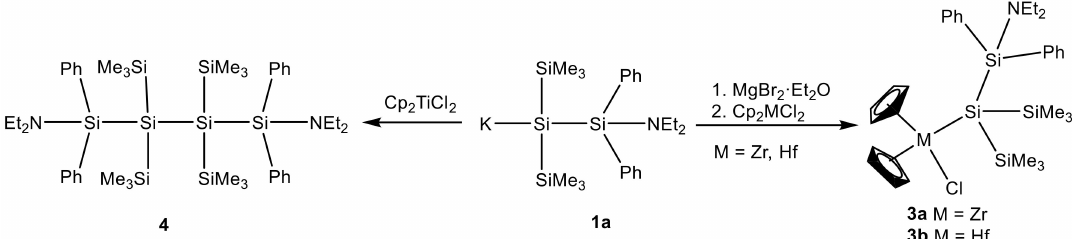
Scheme 2. Reactions of 1a with Cp 2 MCl 2 (M = Zr, Hf) producing the respective β -aminodisilanyl metallocene chlorides 3a and 3b . Reaction of 1a with Cp 2 TiCl 2 causes oxidative coupling, yielding 4